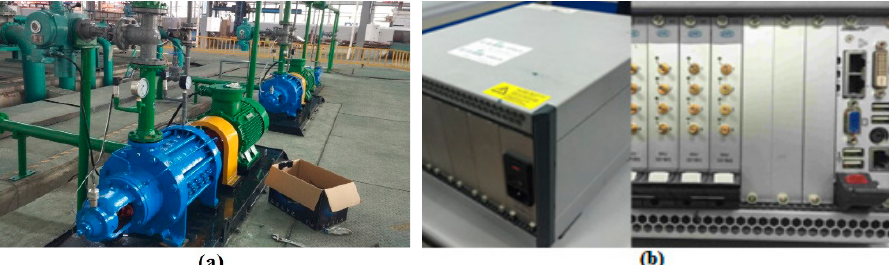
Figure 5. The test system including ( a ) the pump circulation system and ( b ) the INV3020C signal acquisition system.